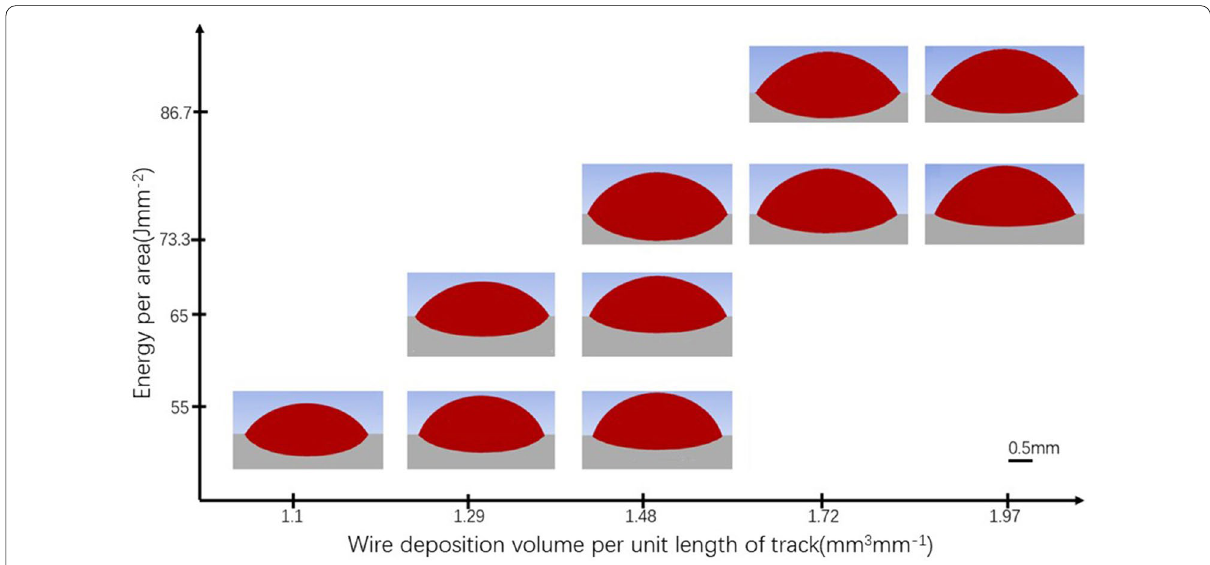
Figure 27 Clad cross-sections at H